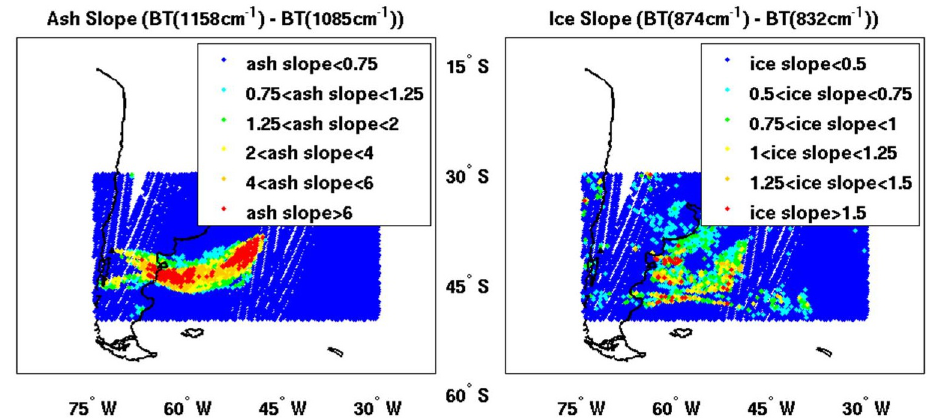
Figure 5. Aerosol signatures, in the form of TIR spectral slopes, as described in the text, for the 5 June 2011 local morning overpass. On the left: the ash spectral slope; on the right: the ice spectral